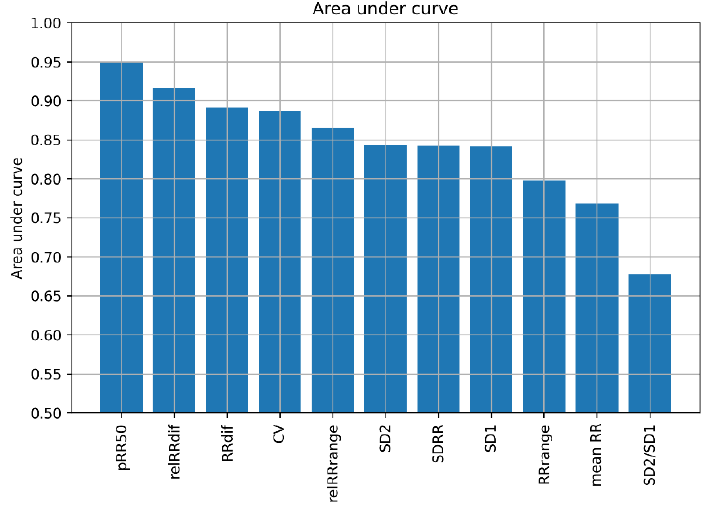
Figure 1. Area under receiver operating characteristic curve (AUC) of heart rate variability features. pRR50—percentage of successive differences between RR intervals greater or equal to 50 ms; SD1 and SD2—standard deviation of points in the Poincare plot across and along the identity line, respectively; SDRR—standard deviation of RR intervals; RRdif—mean of absolute differences between successive RR; CV—coefficient of variance; relRRdif = RRdif/(mean RR); mean RR—mean of RR intervals; RRrange = max(RR) − min(RR); relRRrange = RRrange/(mean RR) (relative RRrange).